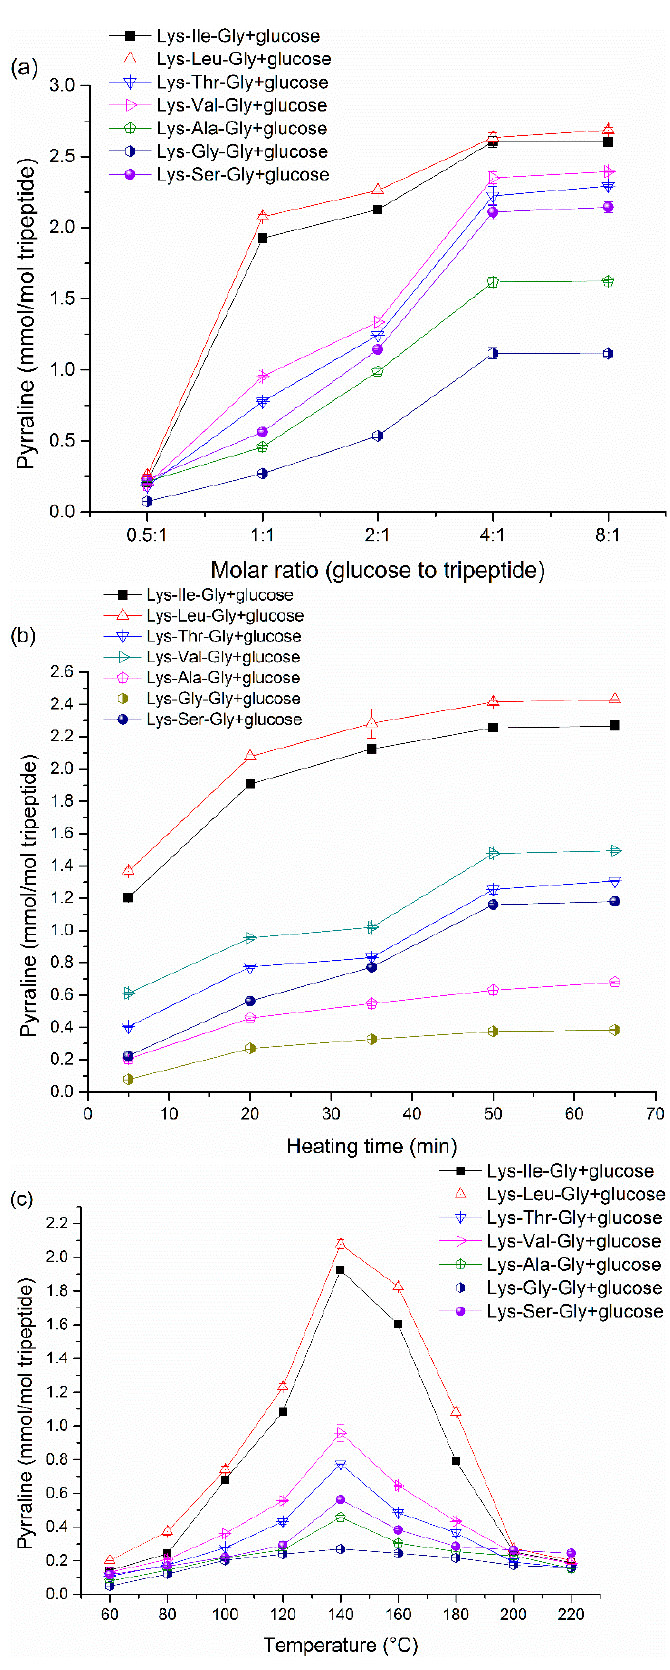
Figure 6. Peptide-bound pyrraline concentration in the heat-treated tripeptide-glucose mixtures, ( a ) tripeptide-glucose mixtures at different initial molar ratios, time 20 min, temperature 140 °C; ( b ) tripeptide-glucose mixtures at various heat-treated times, initial molar ratio 1:1, temperature 140 °C; ( c ) tripeptide-glucose mixtures at different heating temperatures, initial molar ratio 1:1, time 20 min.